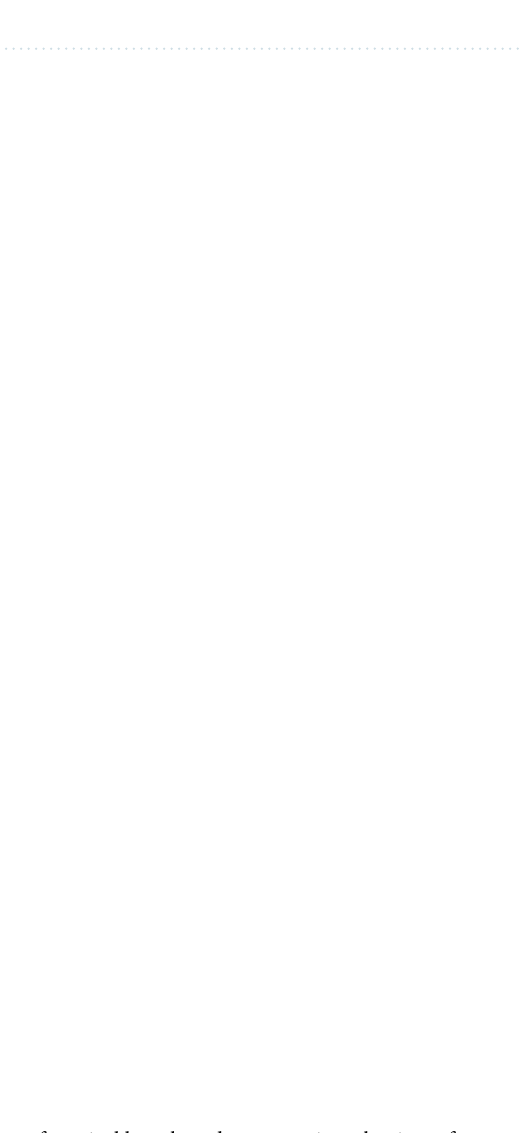
Table 2. Univariate analysis comparing the presence of cervical lymph node metastasis at the time of diagnosis in relation to clinicopathological data of papillary thyroid cancer